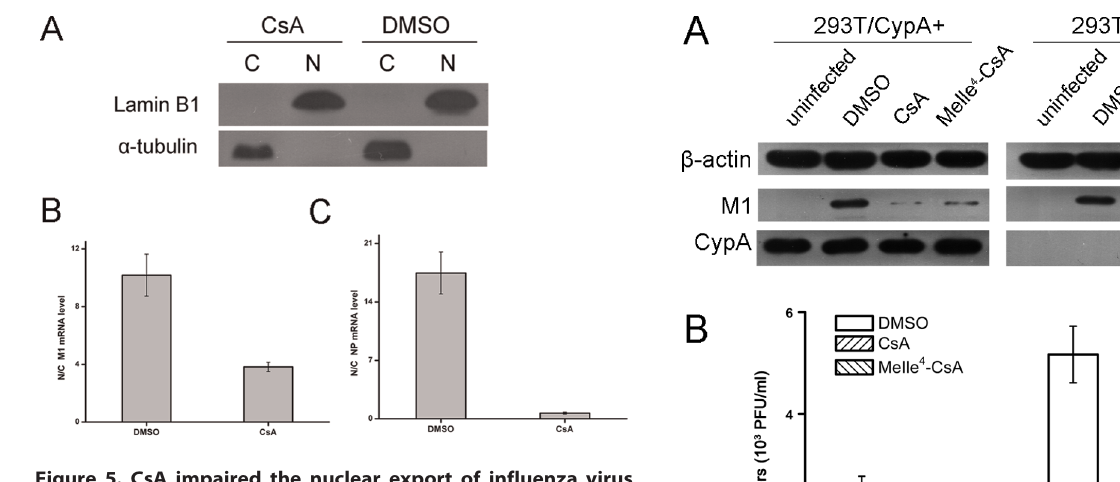
Figure 5. CsA impaired the nuclear export of influenza virus mRNA in the absence of CypA. The 293T/CypA 2 cell line was infected with A/WSN/33 (MOI=0.1) in the presence or the absence of CsA. At 4 h post-infection, Nuclear (N) and cytoplasmic (C) components were isolated from the infected 293T/CypA 2 cell line. One tenth of the components were used for Western blot by anti-alpha-tubulin and anti- lamin B1 (A). The rest of the components were used for the RNA extraction and real time PCR. M1 (B)and NP (C) mRNA levels were quantified by real-time RT-PCR using gene-specific primers. Data are means 6 SD of three separate experiments.